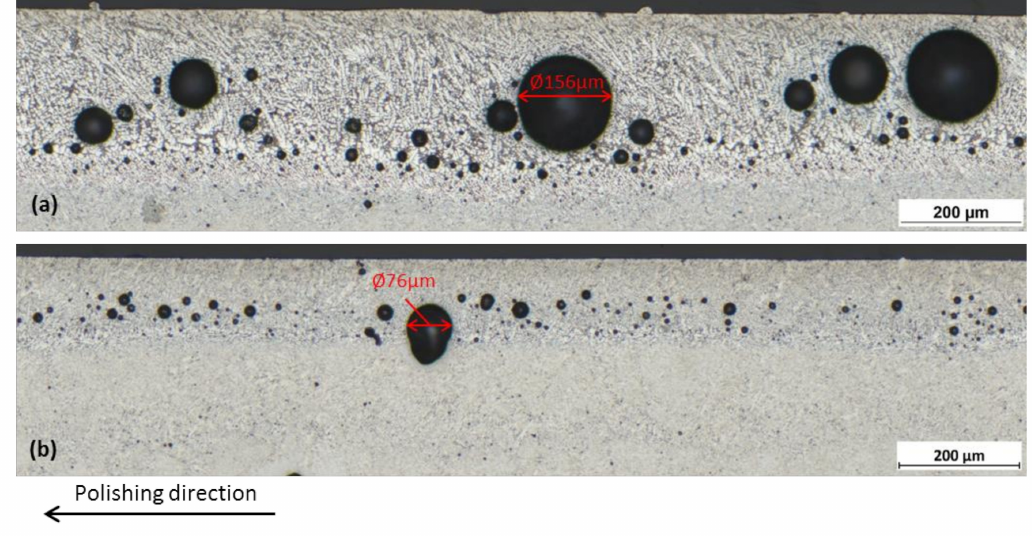
Figure 22. Longitudinal cutting of the remelting zone at position with the highest remelting depth, ( a ) CW-polishing at l = 15–16 mm, ( b ) PW-polishing at l = 12